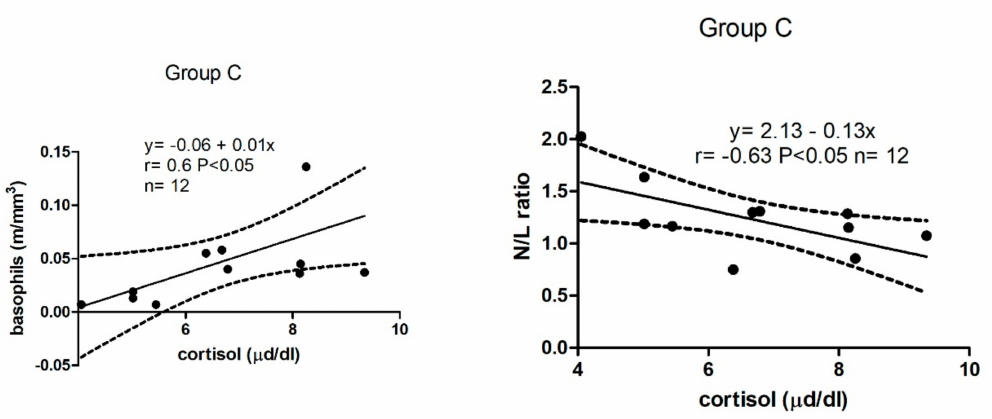
Figure 1. Linear regression model results obtained between serum cortisol and leucocyte profile in Group B (barren jennies) and in Group C (pregnant jennies).